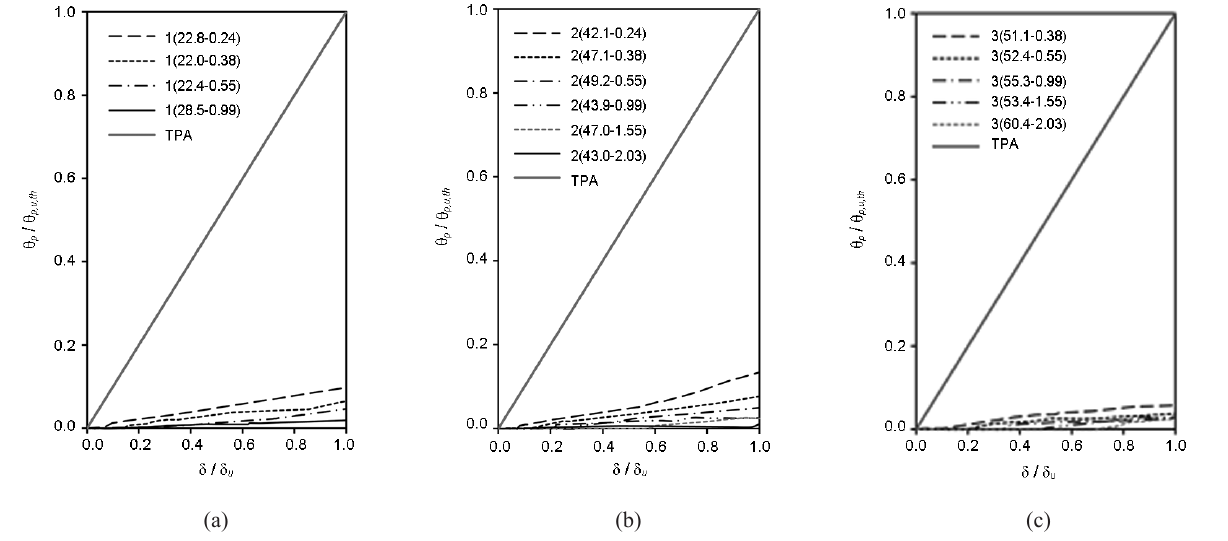
Fig. 7. q p – δ Curves: (a) Series 1; (b) Series 2; (c) Series